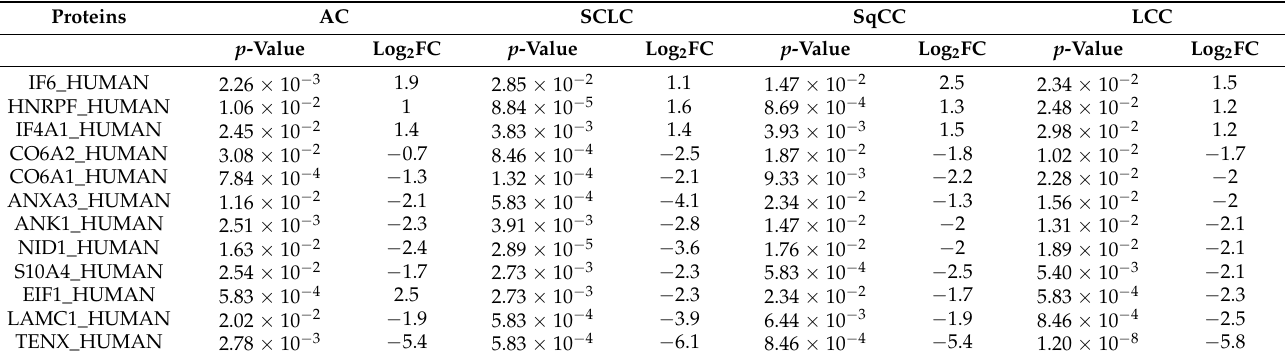
Table 2. Excerpt of the proteins differentially expressed in all four types of LC compared to tumor- adjacent tissue. Proteins discussed in detail in further sections are listed.